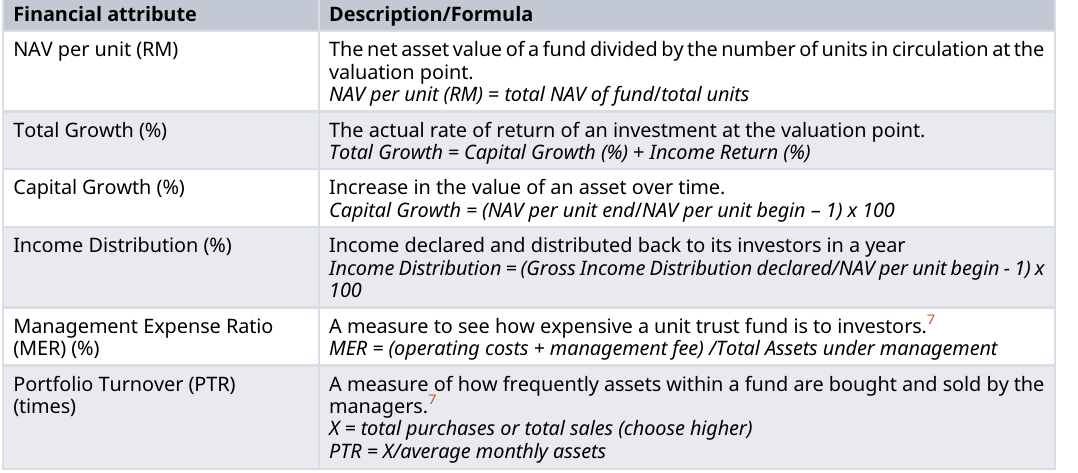
Table 1. The six selected financial attributes that were used in this study. Financial